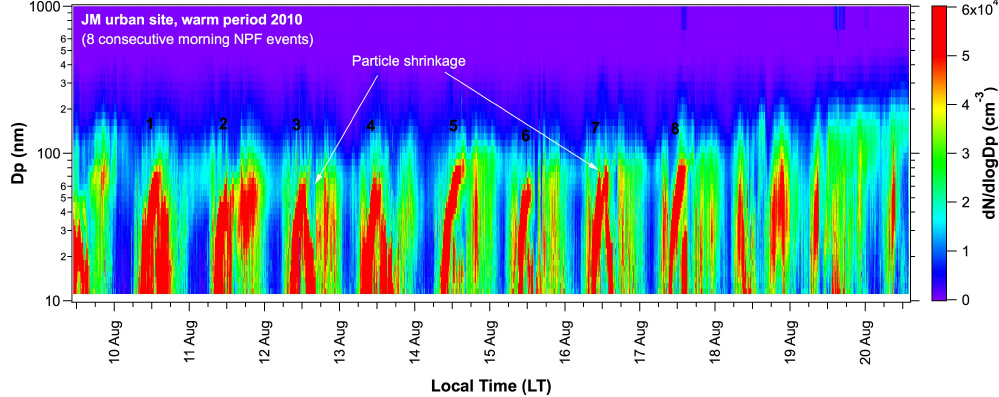
Fig. A1. The measured particle number size distributions during eight consecutive NPF events at the urban site from the 10 to the 17 August 2010. Among them there were two particle shrinkage events on the 12 and the 16 August 2010.